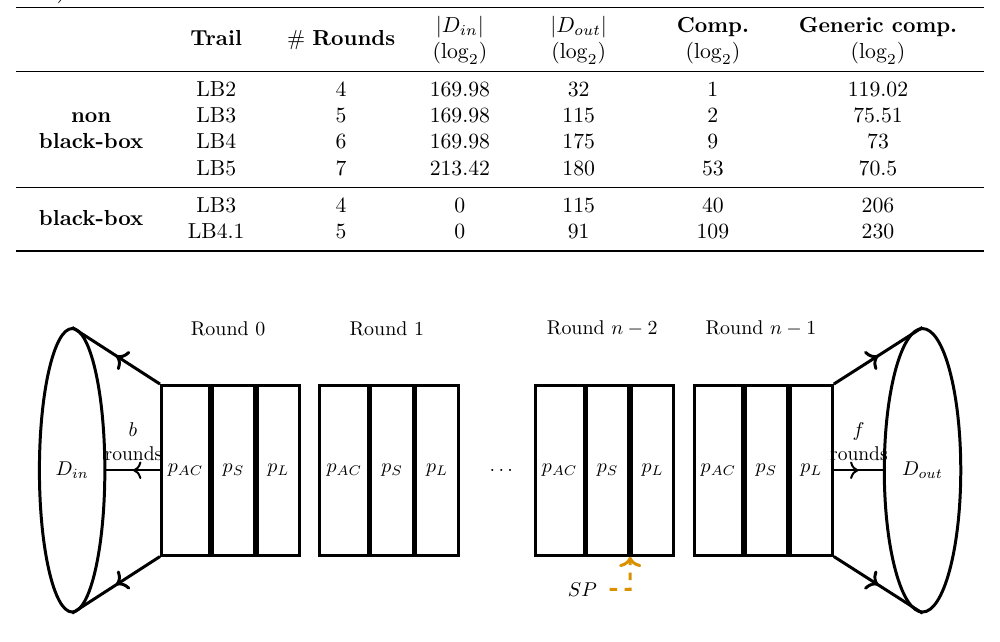
Table 3: Parameters of the limited-birthday distinguishers for Ascon permutation (320 bits).